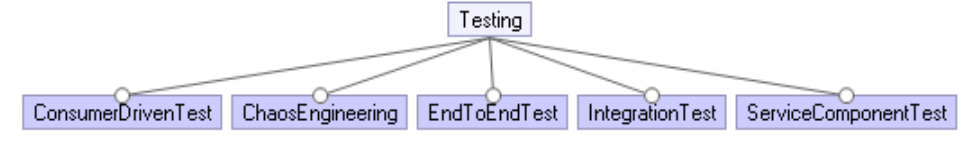
Figure 11. Feature diagram of testing.